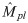
Data set M vs. v6M (or 10−2
D) and the model outputs M^pl for women patients’ population.